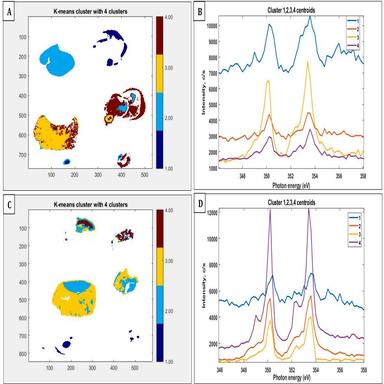
K-means clustering analysis results for the NMI region at ambient temperature (A, B) and after the annealing process (C, D). Four distinct clusters were identified, each represented by a unique color in the spatial distribution maps (A, C) and a corresponding number in the centroid spectra plots (B, D). The numbers in the spectra plots correlate directly with the colors used in the spatial maps to represent the clustered NMIs.